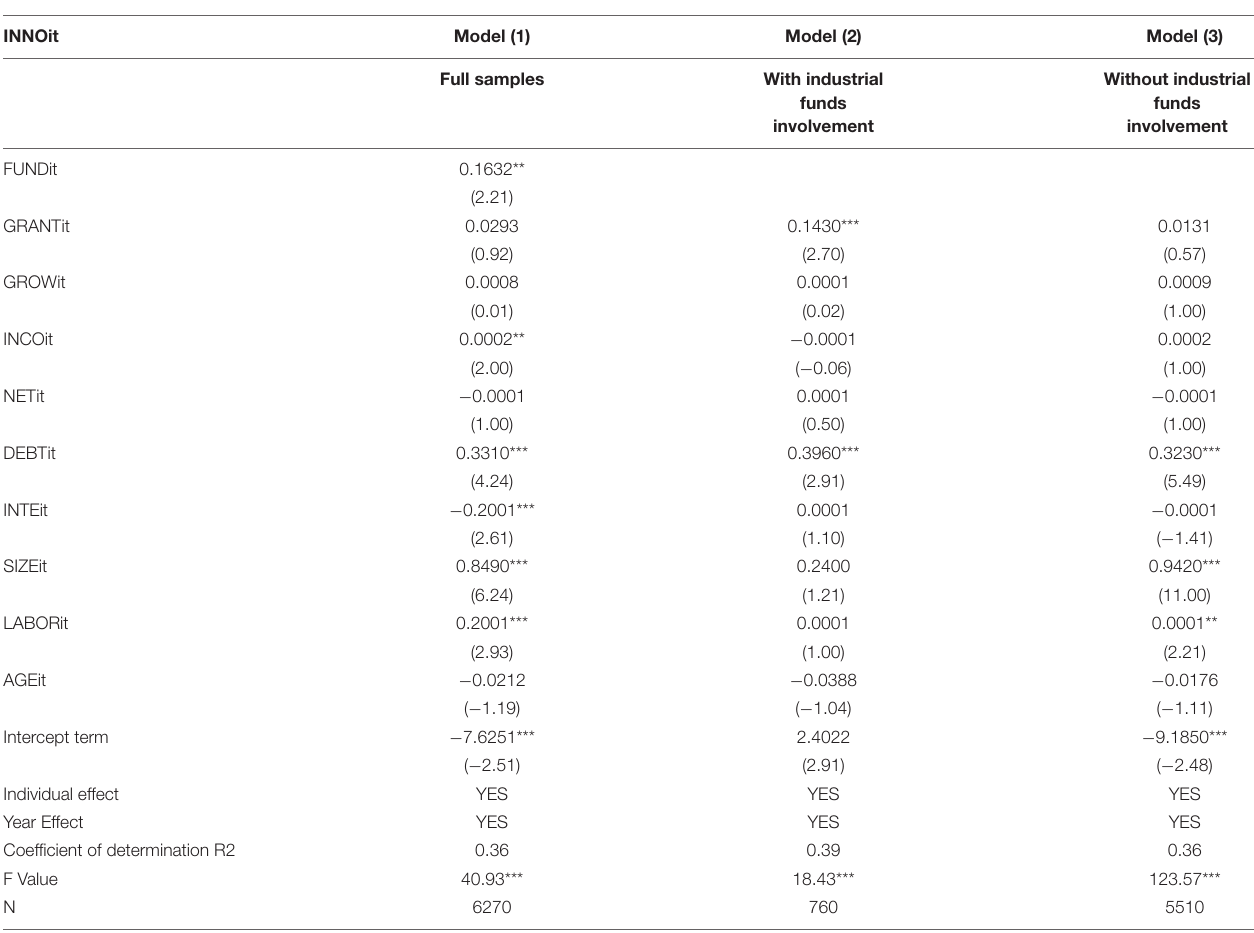
TABLE 2 | Empirical